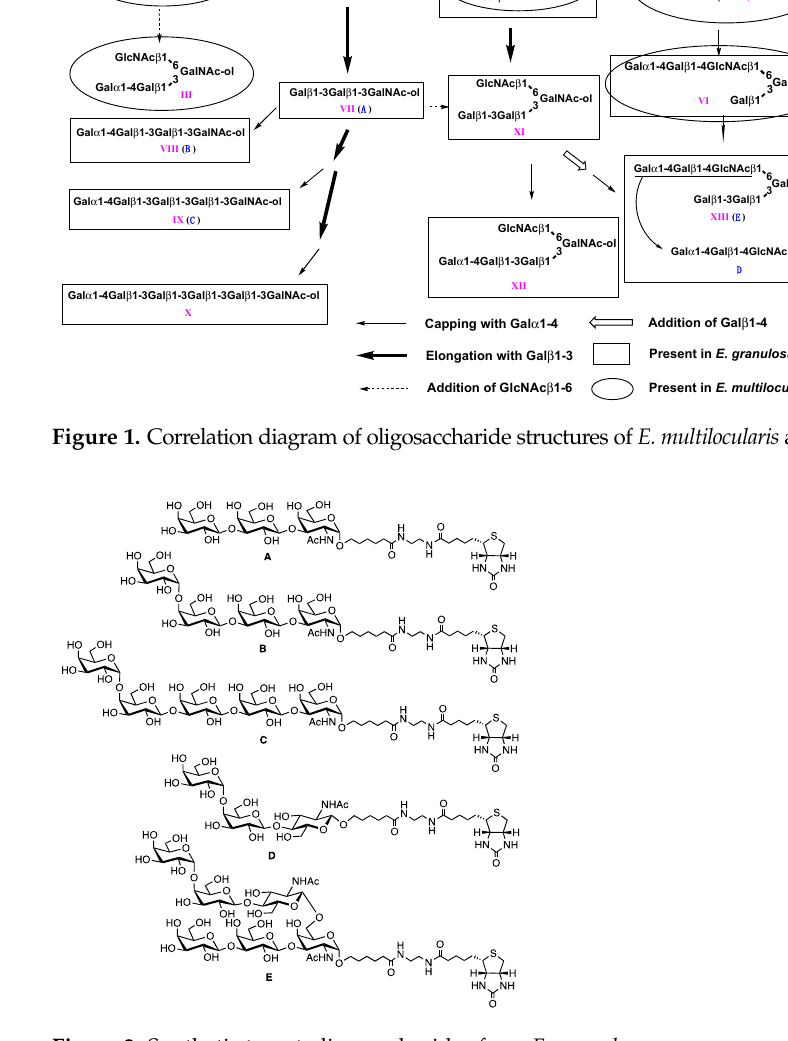
Figure 3. Synthetic strategy of tri-, tetra, and pentasaccharides. Suitably protected monosaccharide derivatives ( 4 , 5 , 9 , and 12 ) were chosen as build- ing blocks. The 5-(Methoxycarbonyl)pentyl group was chosen as the temporary protecting group for all the target compounds to ensure future conjugation with biotin for the ELISA assay as previously shown by us [8]. The synthetic routes for target compounds A – C are outlined in Schemes 1–6. Initially, disaccharide acceptor 8 was prepared in a way that